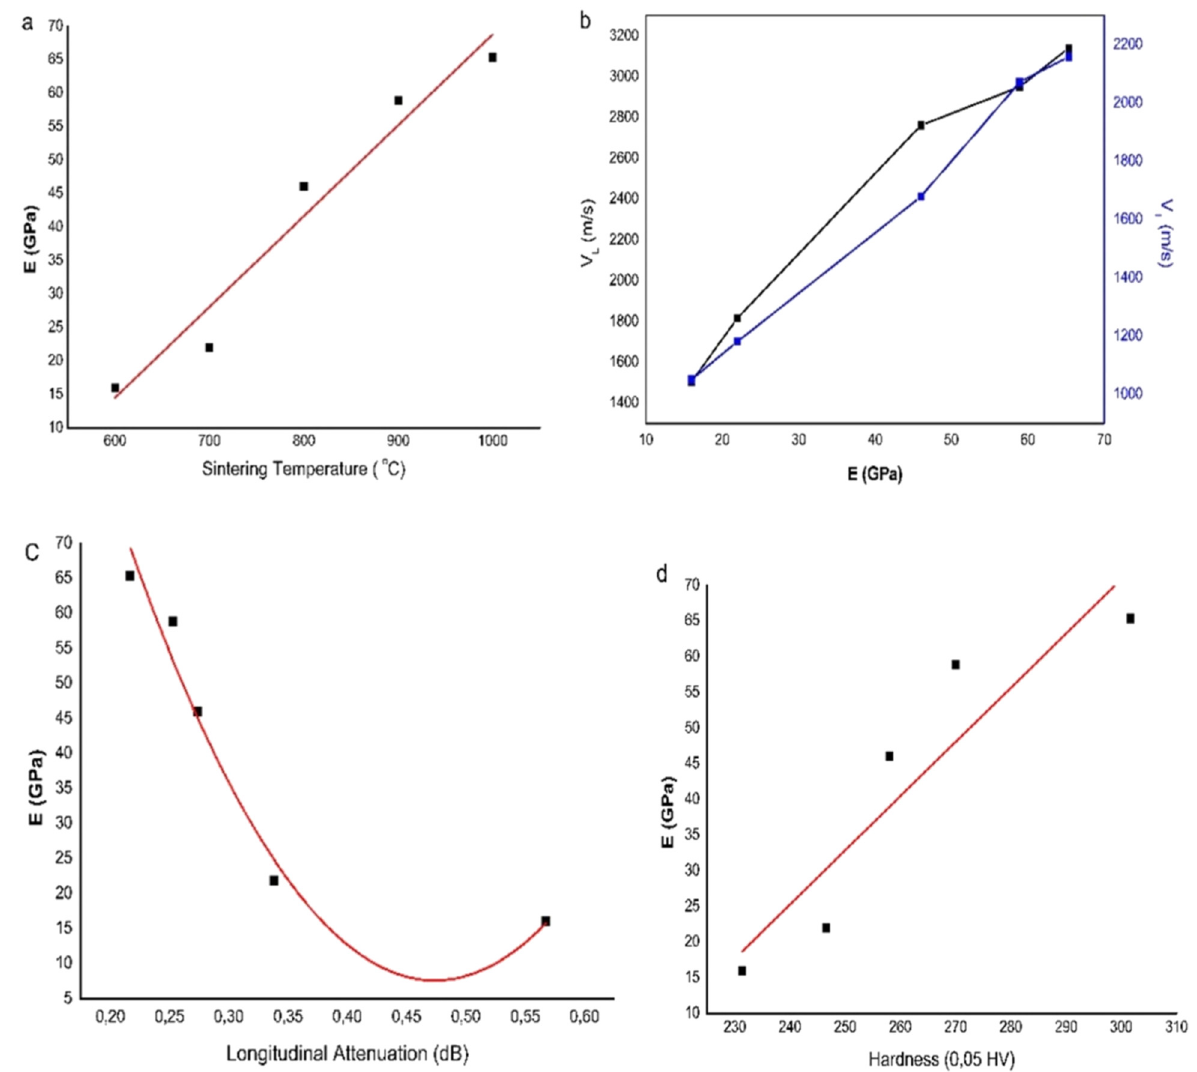
Figure 2: The relationship between E values and the physical – mechanical properties of